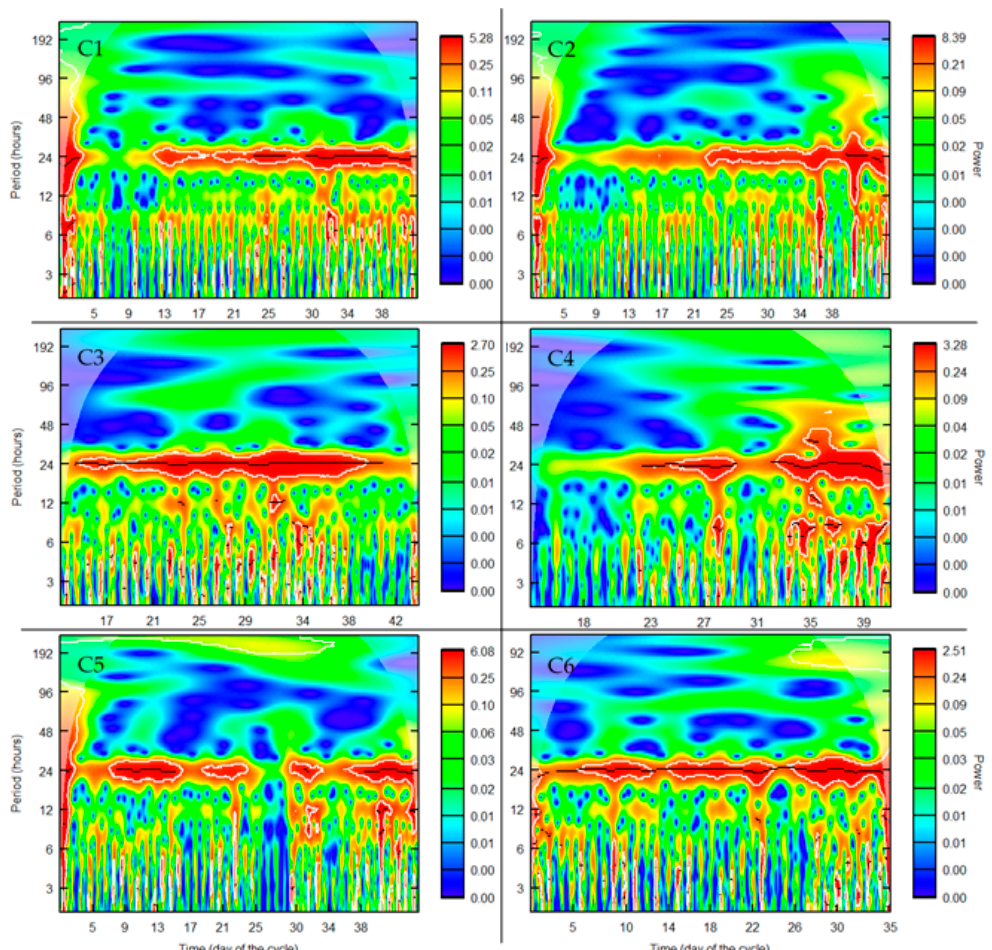
Figure 5. Wavelet analysis of the six cycles of animal activity recorded.